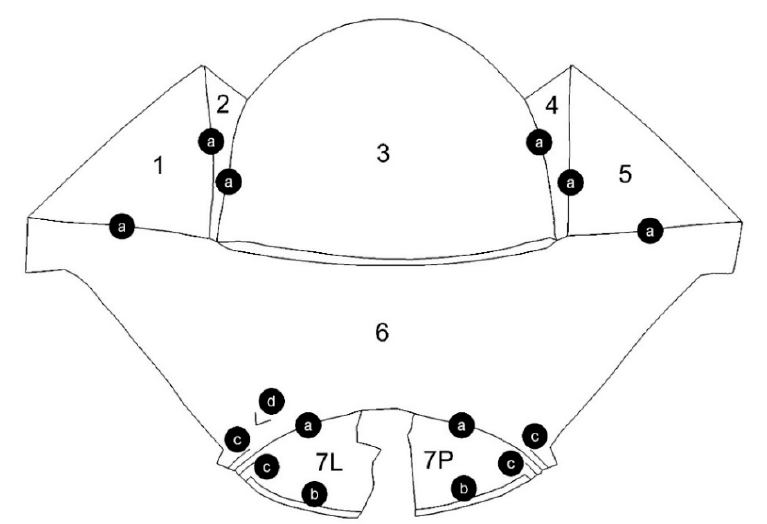
Figure 8. Numbering of surface patches: 1–7 and denotation of edge configurations: (a) one-edge; (b) two-edge; (c) four-edge; (d) two-edge with a gap.